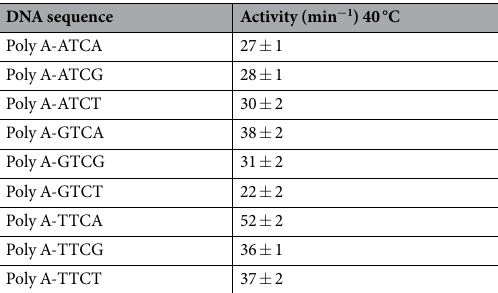
Table 2. A3A enzyme activity for DNA sequences.